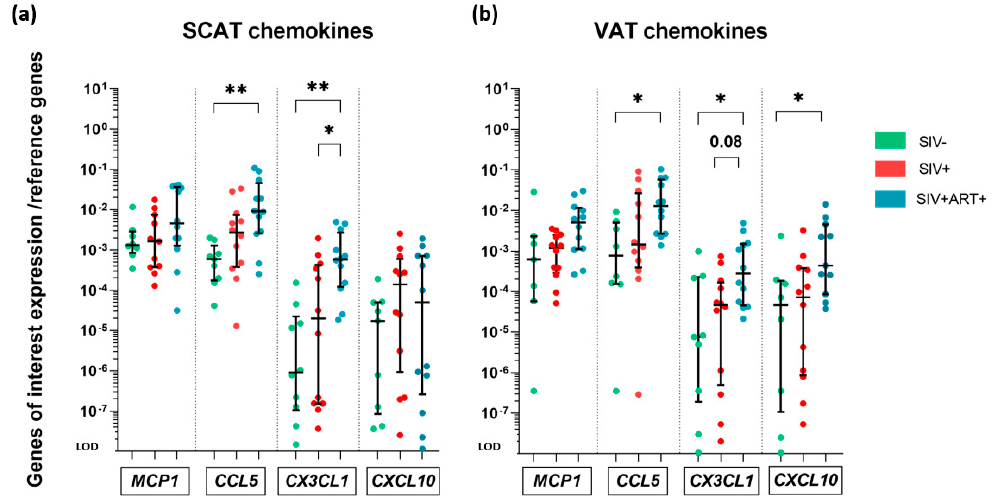
Figure 5. Gene expression analysis of AT chemokine production, at the whole-tissue level. RT-qPCR analysis of the mRNA expression of genes encoding MCP-1, CCL5, CX3CL1 and CXCL10 chemokines within the SCAT and VAT in the three groups of animals: SIV − (green), SIV+ (red), and SIV+ART+ (blue). Expression of the genes of interest was compared with that of the 18S and PPIA housekeeping genes. The limit of detection (LOD) was set to the difference vs. the mean level of housekeeping gene expression after 20 cycles, i.e., a 10 − 8 -fold difference. ( a,b ) Expression of MCP1 , CCL5 , CX3CL1 and CXCL10 within SCAT ( a ) and VAT ( b ) in the three groups. The results are quoted as the median [IQR]. Kruskal–Wallis tests associated with Dunn’s multiple comparison test and Mann–Whitney tests were used for unpaired and paired comparisons, respectively. Only significant results and trends are shown: * p < 0.05, ** p <